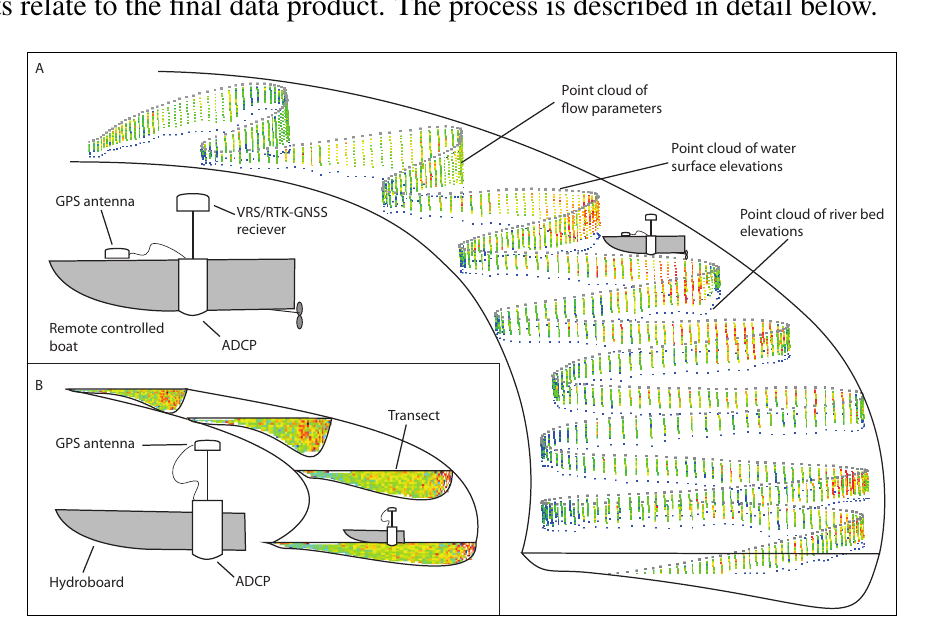
Figure 2. Diagram of the flow measurement set-up and concept. ( A ) The new spatial modeling of flow vectors as a 3D point cloud containing surface points, flow velocity and direction points in the water column and river bed elevation points; ( B ) This subfigure contrasts the more traditional method of representing flow as a series of